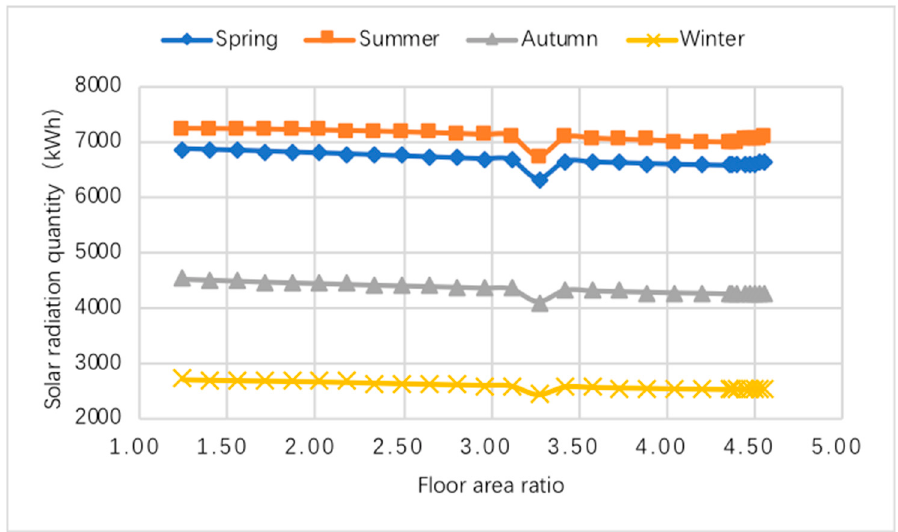
Figure 6. Solar radiation analysis of each season.